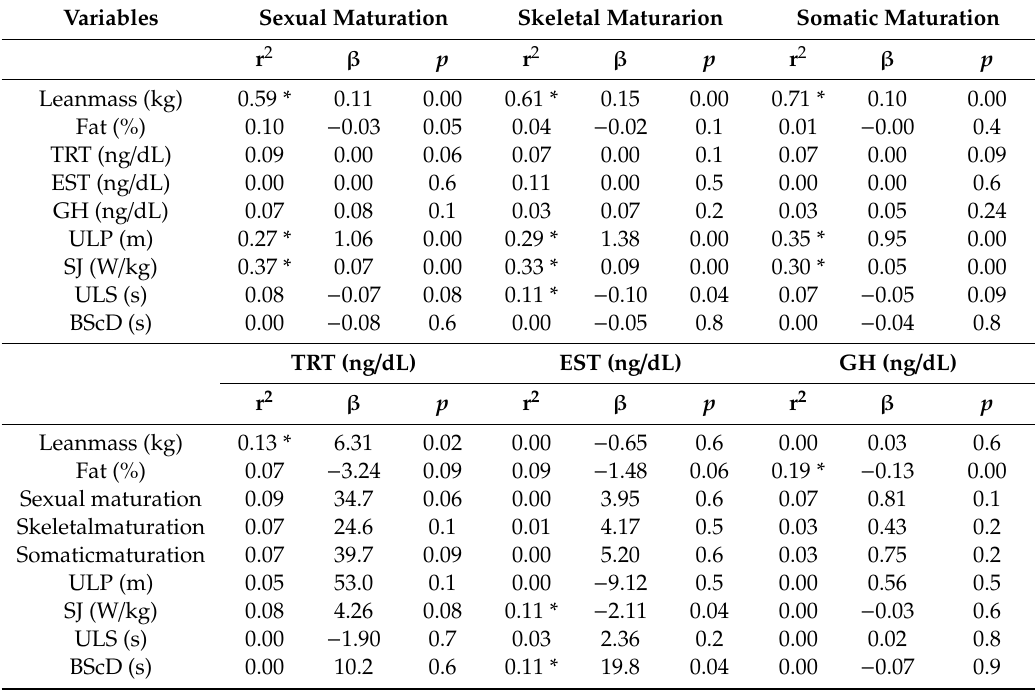
Table 4. Linear regression of hormonal levels and biological maturation with the study variables. Variables Sexual Maturation Skeletal Maturarion Somatic Maturation